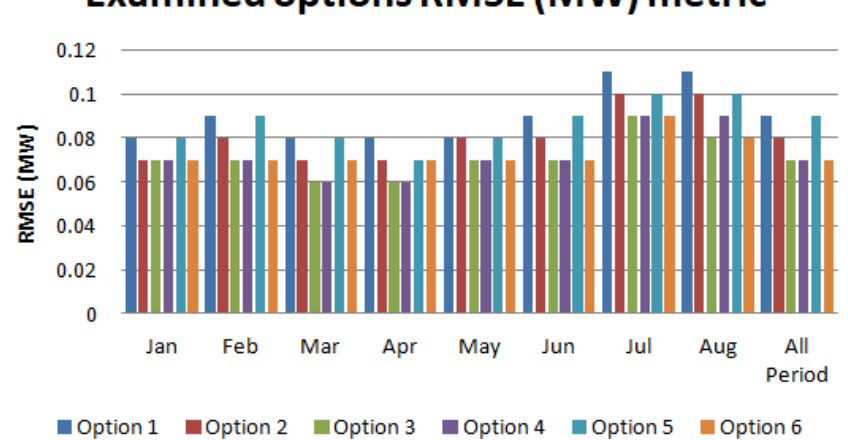
Figure 5. Root mean squared error (RMSE) (MW) metric results for examined options (period January–August 2018).